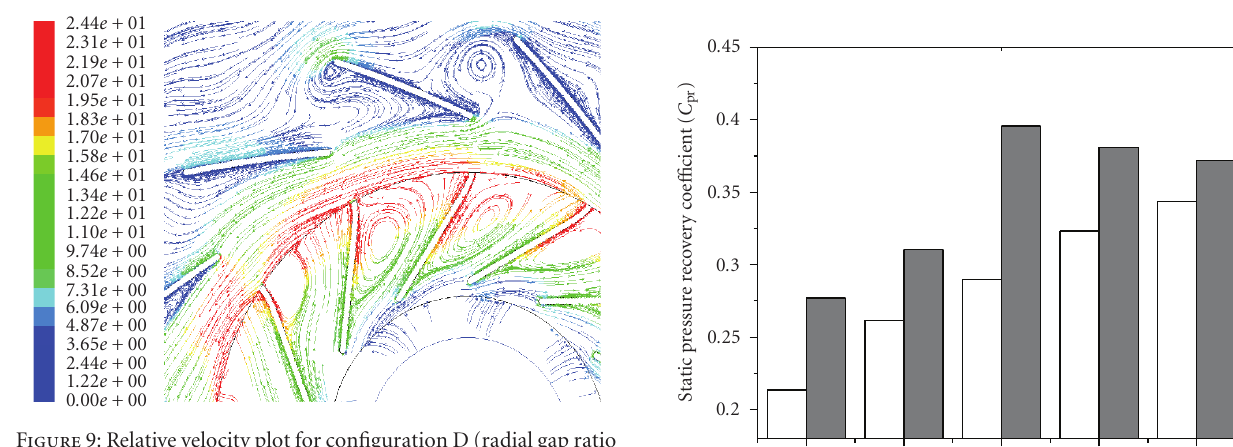
Figure 9: Relative velocity plot for configuration D (radial gap ratio = 0.20).